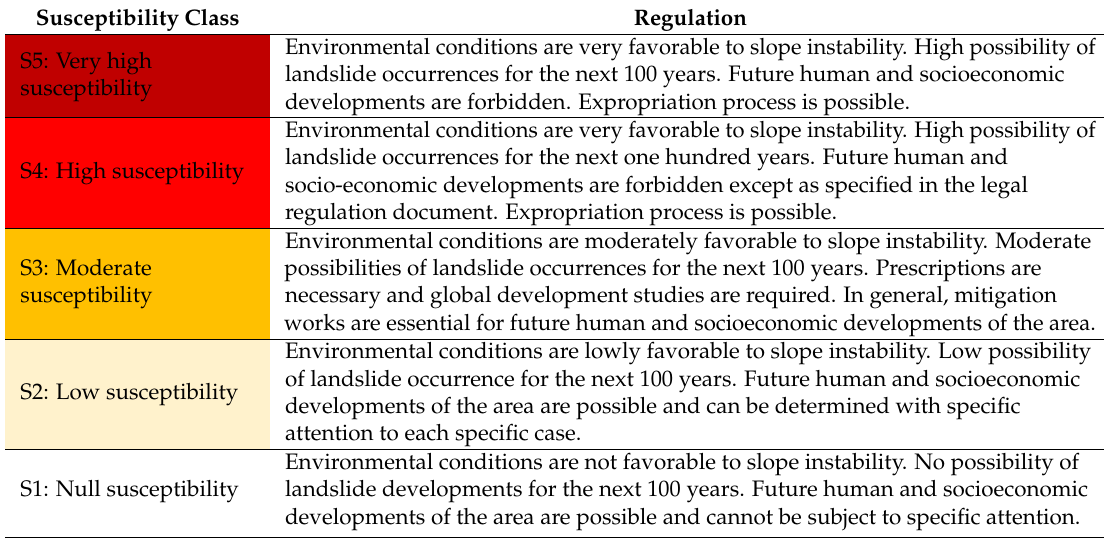
Table 1. Susceptibility class used for the Landslide Expert Susceptibility Map produced for the PPR in La Trinit é